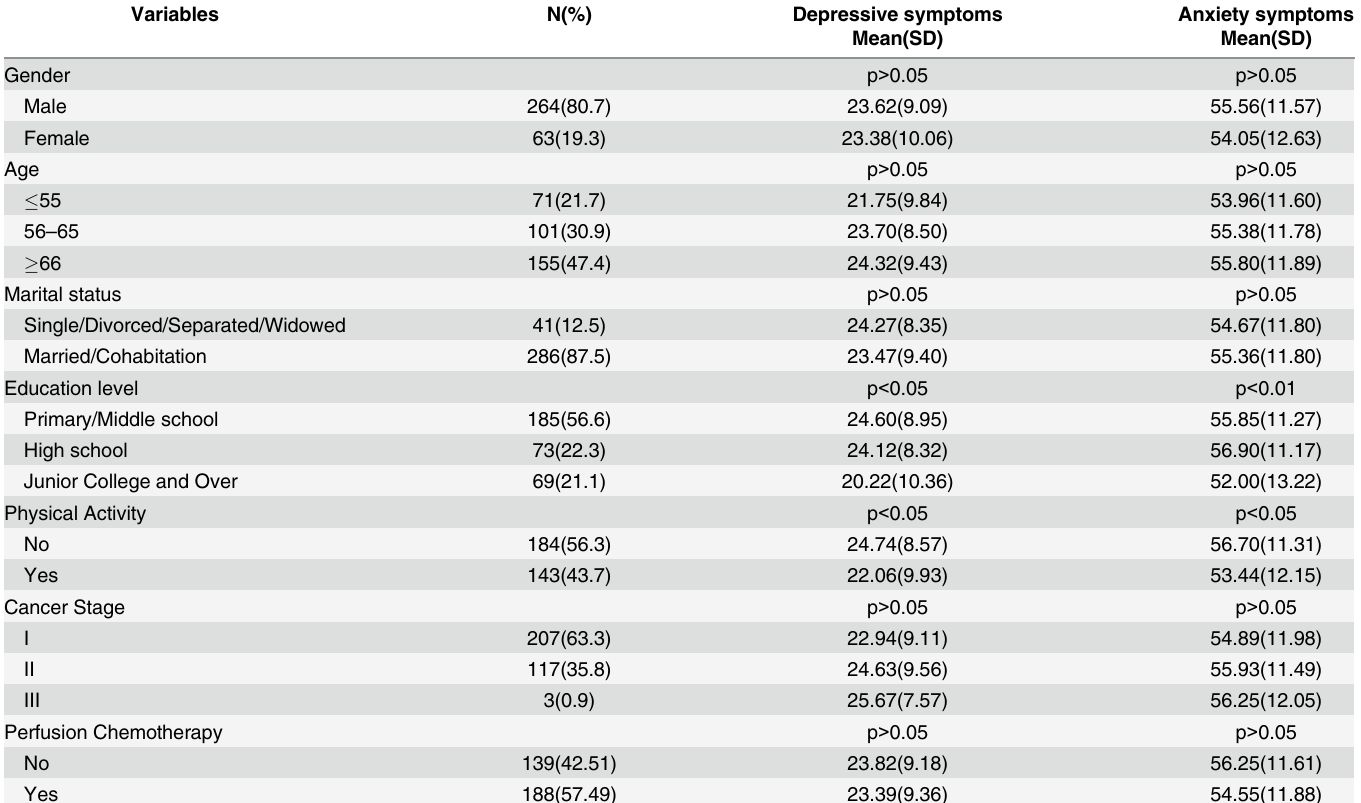
Table 1. Demographic and clinical characteristics of subjects and the distributions of depressive and anxiety symptoms among bladder cancer patients.